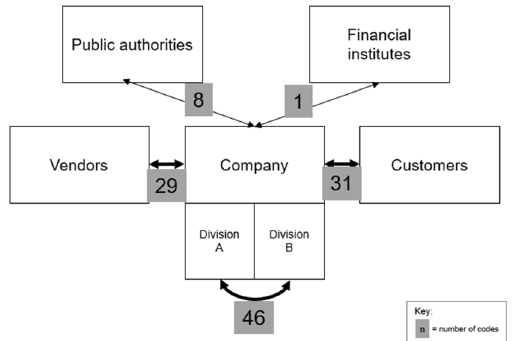
Fig. 10 Interfaces (placement of activities within the supply chain) addressed in the